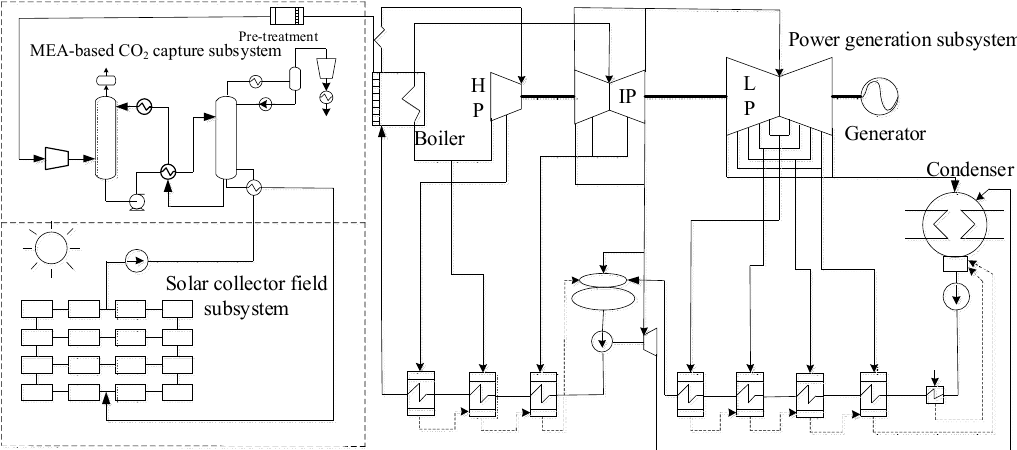
Figure 3. Solar-aided CO 2 capture coal-fired power generation (SA-CC-PG) system.